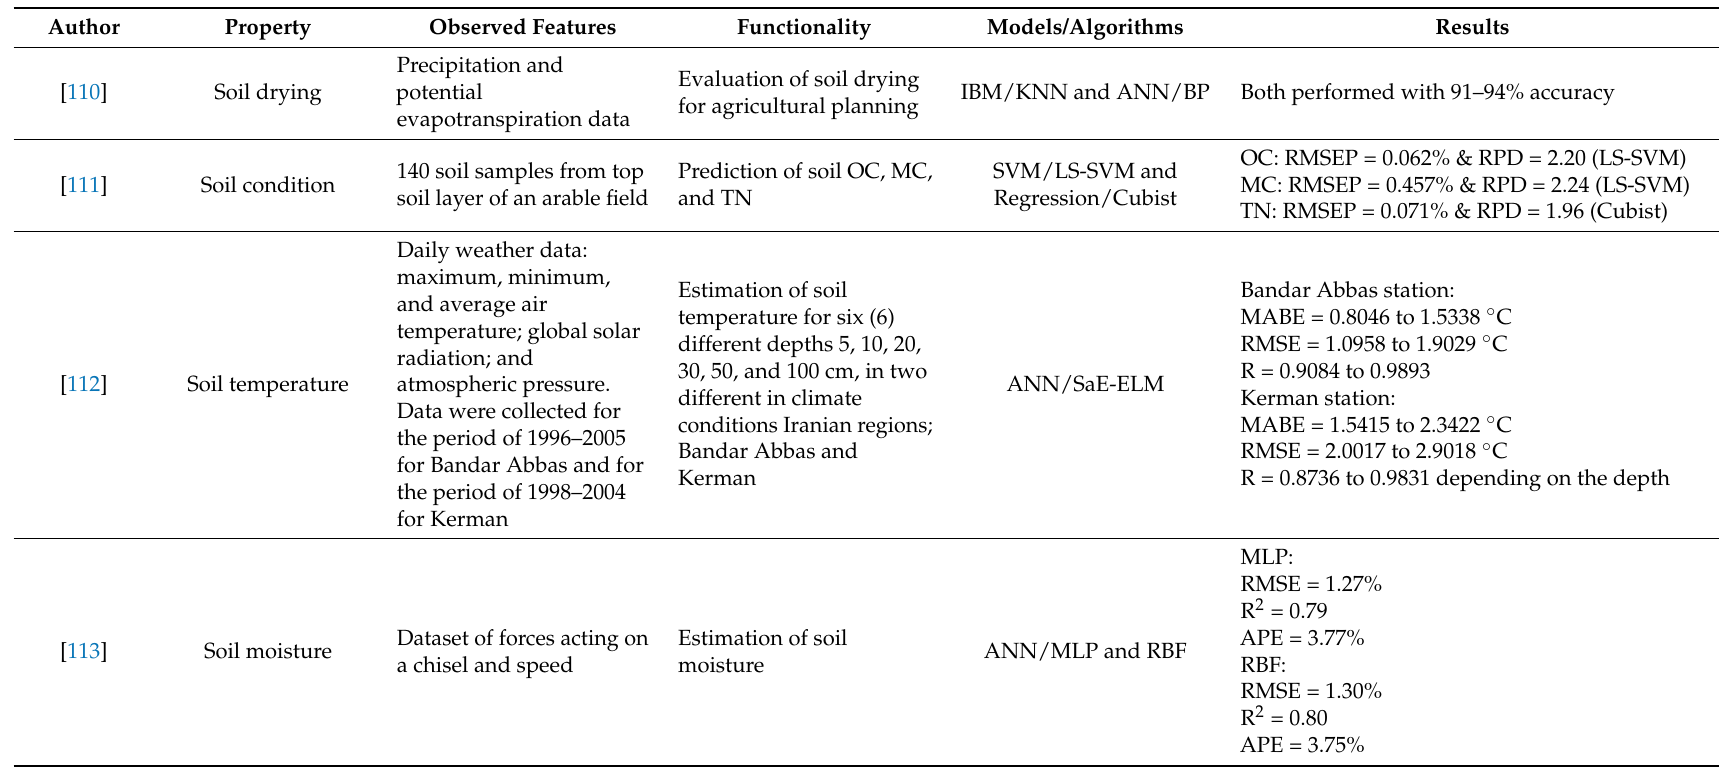
Table 13. Soil management